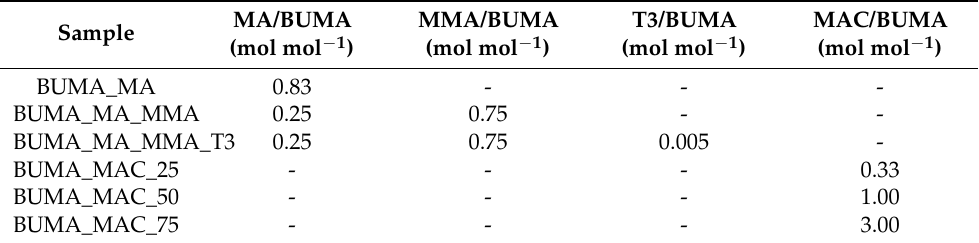
Table 1. Molar ratio of reagents adopted for the synthesis of butyl methacrylate (BUMA)-based polymers. MA = methacrylic acid; BUMA = n-butyl methacrylate; MMA = methyl methacrylate; T3 = pentaerythritol triacrylate; MAC =